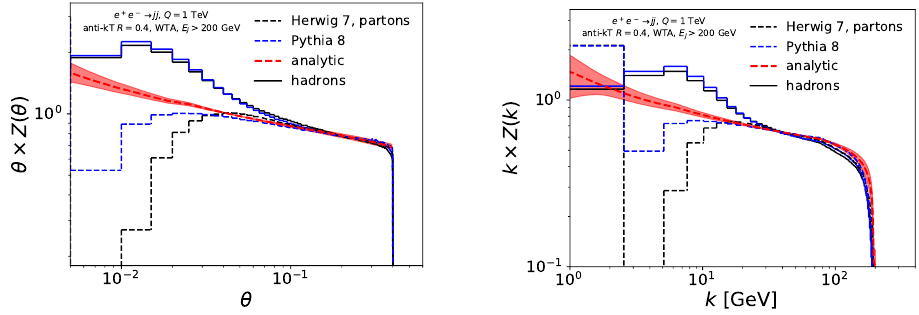
Figure 9 . The jet shape as function of angle (left panel) and transverse momentum (right panel), predicted by Herwig (black), Pythia (blue) at parton (dashed) and hadron-level (solid), and obtained from our analytic calculations including perturbative uncertainties (red curve with band).